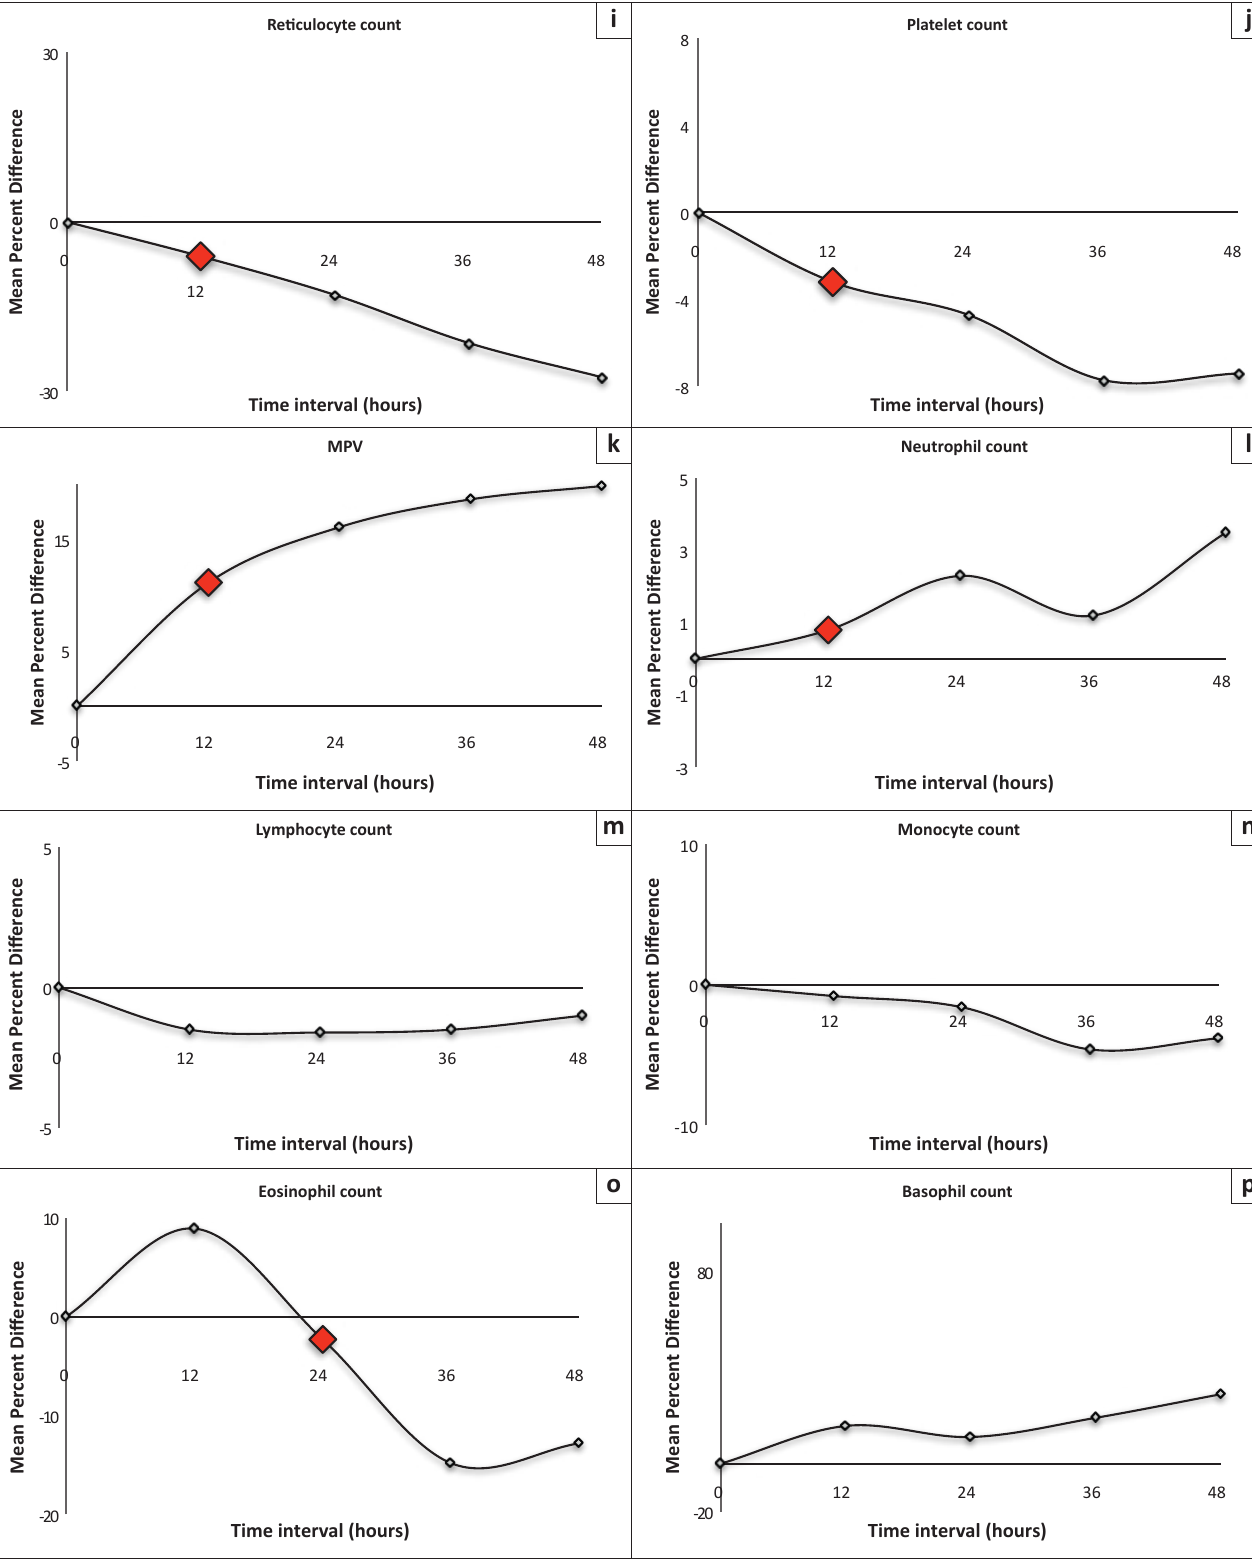
The mean percentage difference for full blood count, differential count and reticulocyte count was plotted against time in hours from the value at time zero. The number of specimens at 36 and 48 hours after collection were 39 and 29, respectively, owing to insufficient sample for analysis or partial aspiration failure. The stability of a parameter was defined in relation to the precision of the ADVIA® 120 analytical method. A parameter was considered stable, when its difference was smaller than one coefficient of variation ( % ) of the assessed method. The red diamond indicates the maximum time point at which specimens were stable. FIGURE 1 (Continues...): Stability analysis (mean percent difference) at room temperature (18 °C – 24